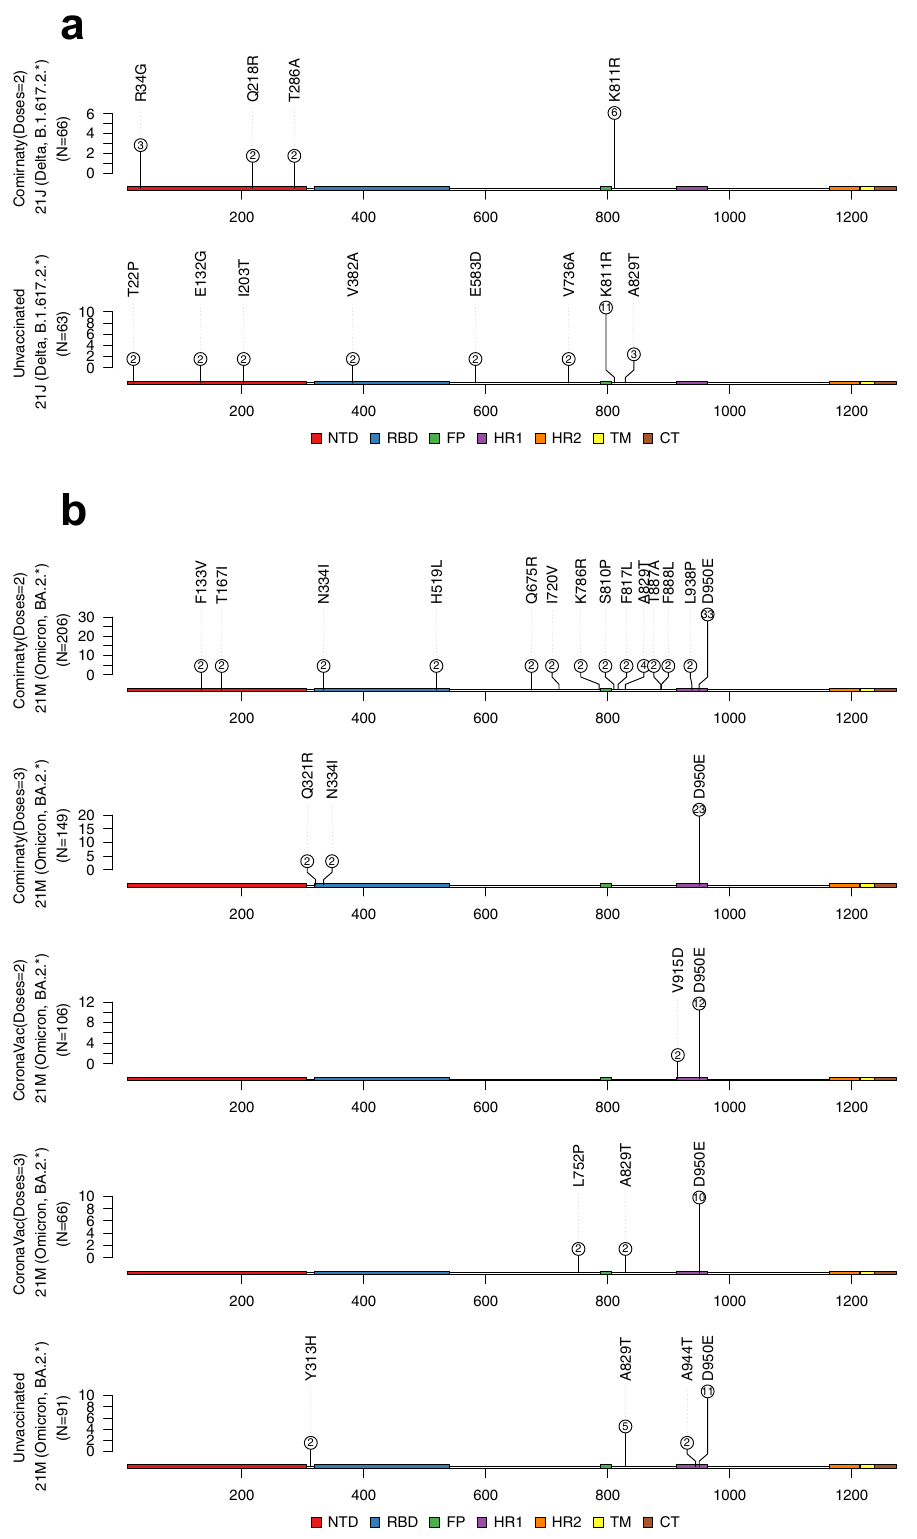
Fig. 4 | Recurrent spike mutations identi fi ed in unvaccinated and vaccinated Delta and Omicronsamples. Thenumbers in eachcirclerepresent the number of mutations identi fi ed in samples in respective groups. a Identi fi ed within-host mutations in Delta samples (the data for group CoronaVac (Doses=2) 21J (Delta,